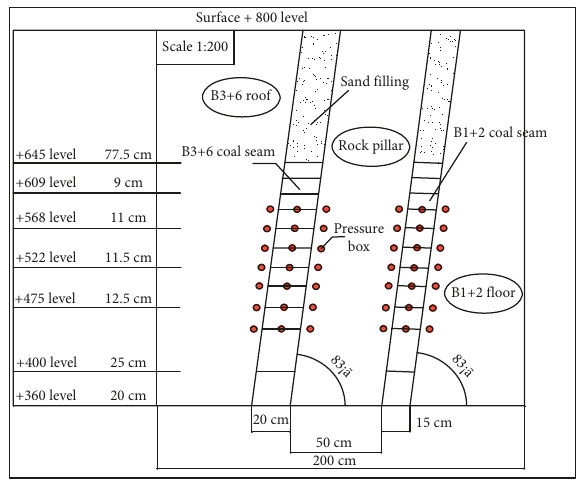
Figure 3: Layout of stress measuring points.